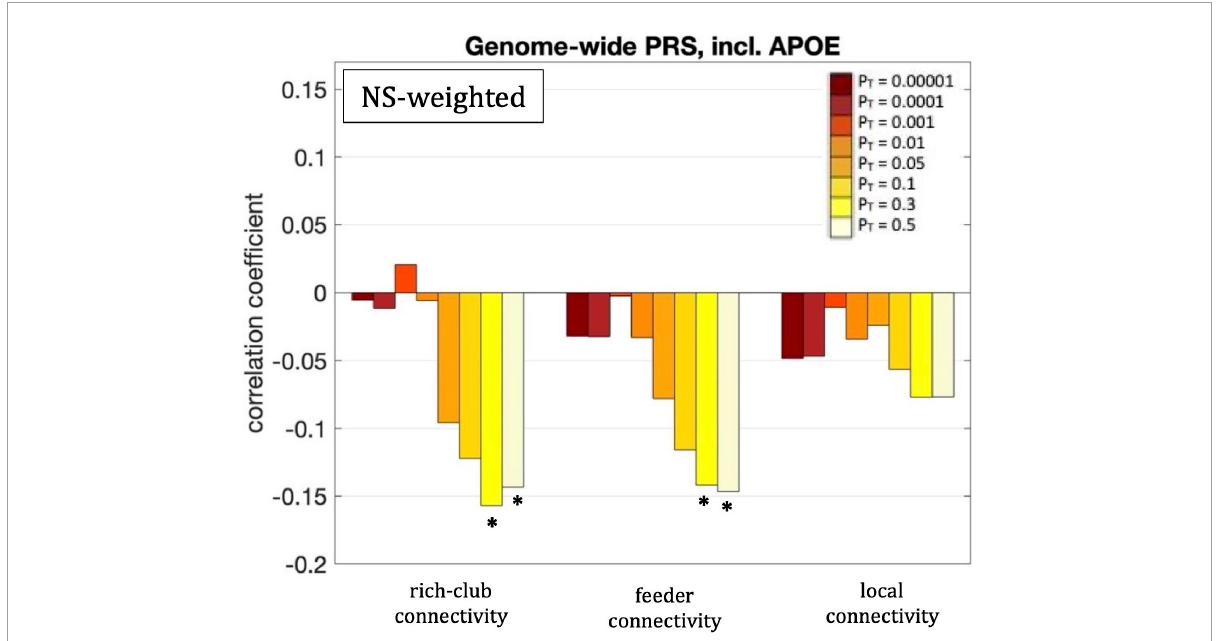
FIGURE8 Correlation coefficients between the rich-club, feeder and local connectivities and the genome-wide PRS including APOE , for the eight different values of P T . Asterisks indicate p -values that survived multiple comparison